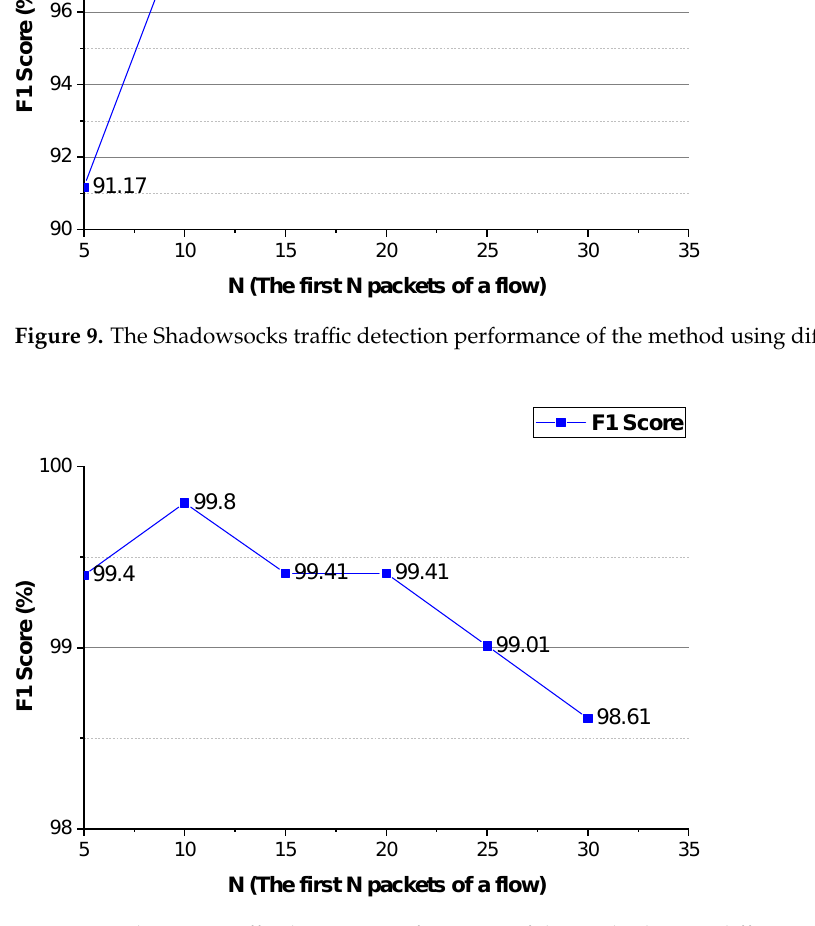
Figure 10. The VPN traffic detection performance of the method using different N